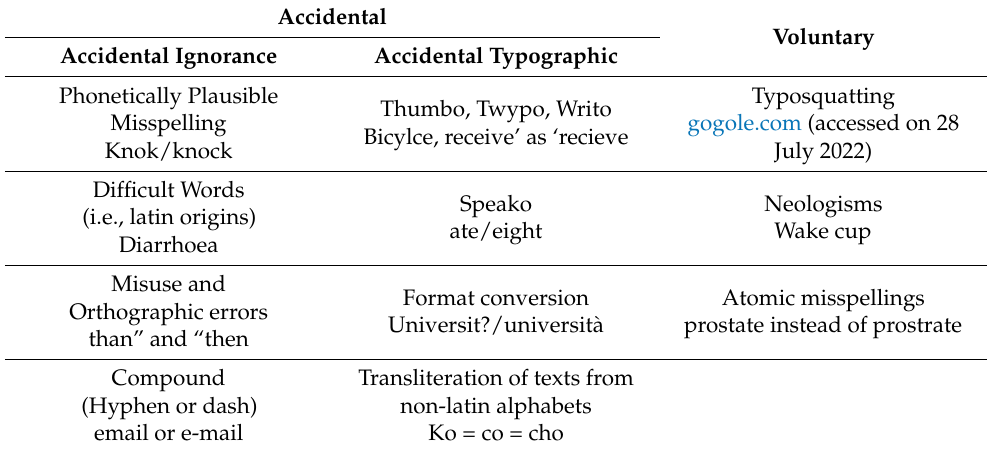
Table 1. Misspellings’